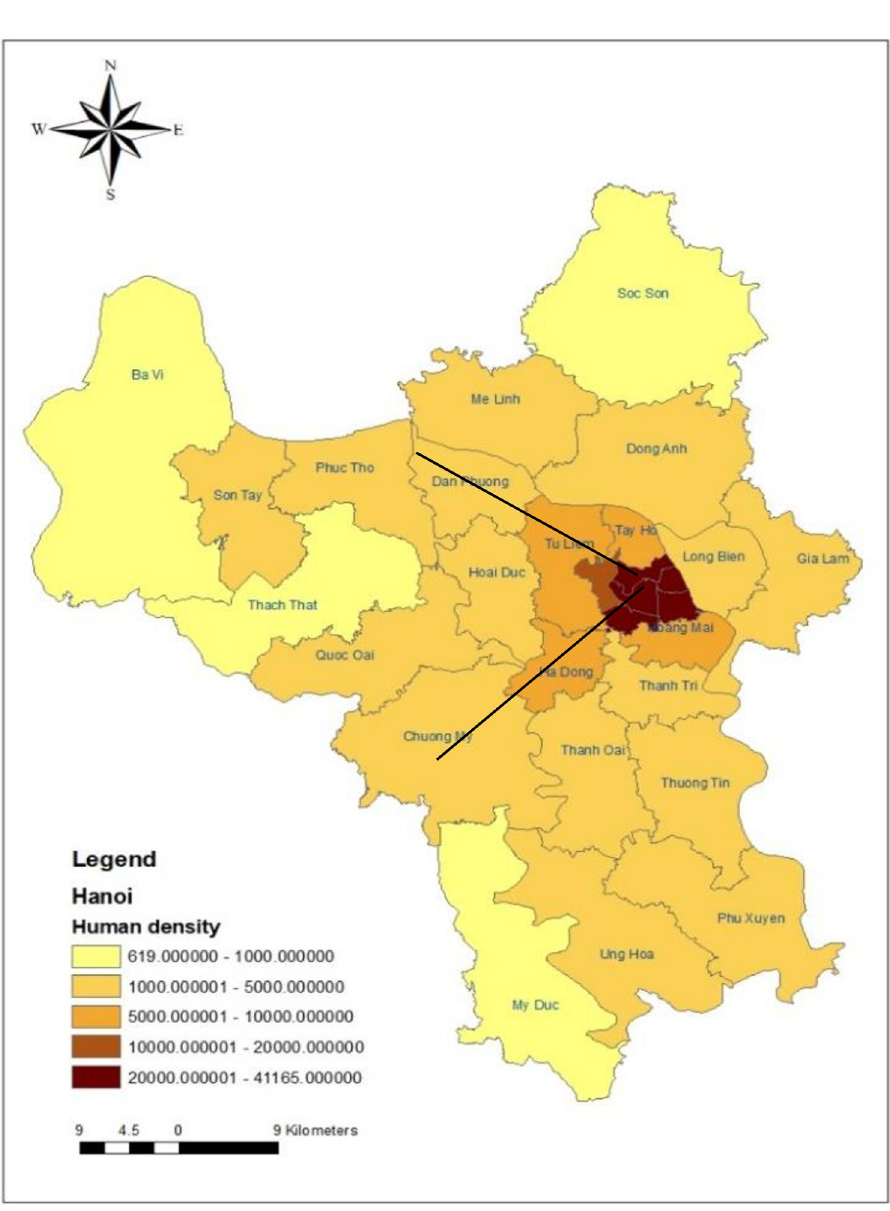
Fig 1. Map of Hanoi with transects through the study